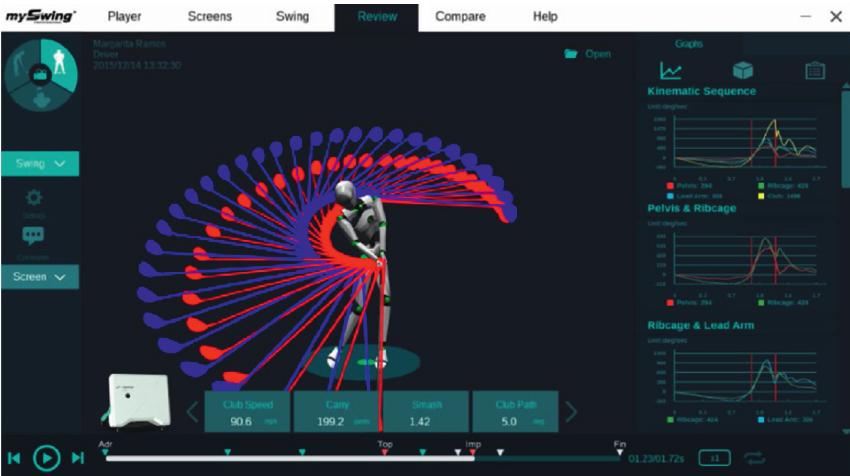
Figure 2: Real-time playback and cloud storage functions of MySwing Professional.